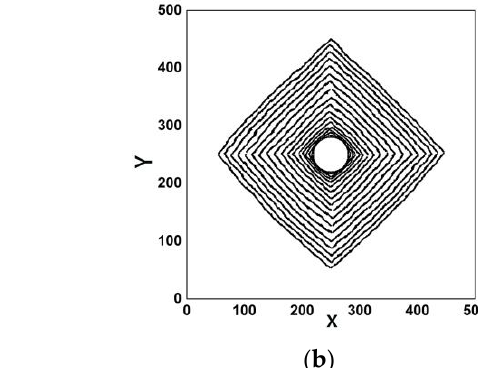
50 .  . Figure 4a is the